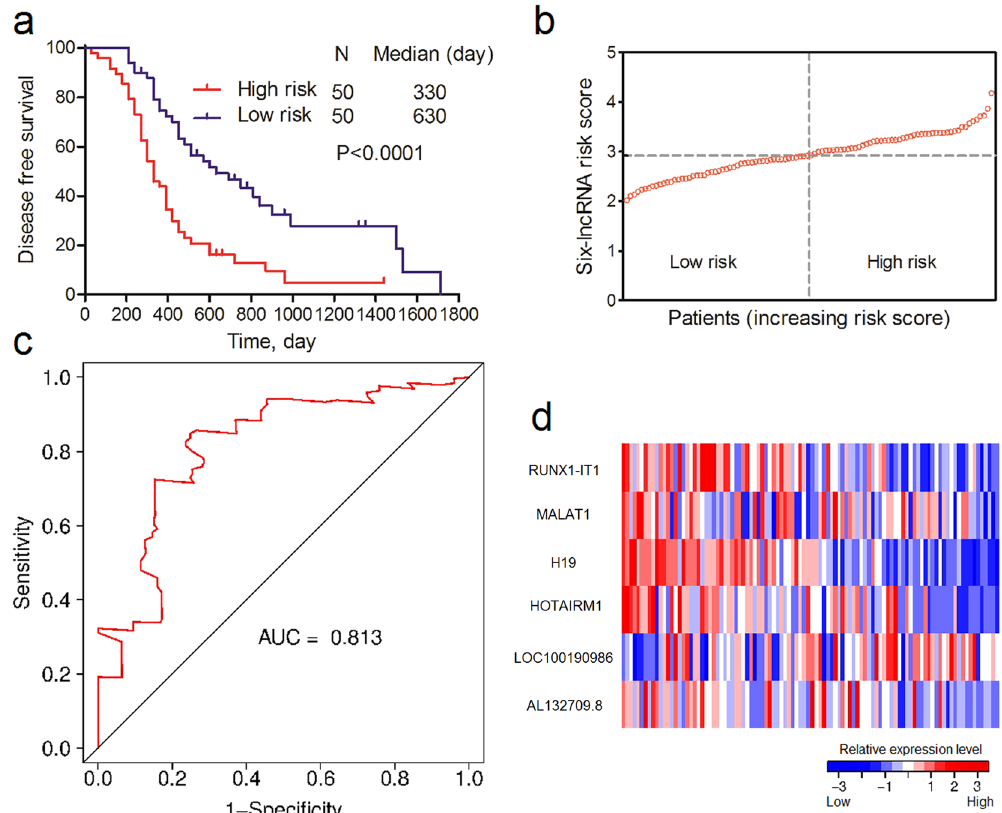
Figure 1. Association between the six-lncRNA signature and DFS of OvCa patients in GSE9891 training cohort. ( a ) K-M curve of DFS between low- and high-risk patients. ( b ) Risk scores of each patient in the GSE9891 training cohort (sorted by risk score). ( c ) Time-dependent ROC curve analysis of the DFS prediction based on the risk score with three years as the time point. ( d ) Expression heat map of the six lncRNAs in OvCa patients in the GSE9891 training cohort (sorted by risk